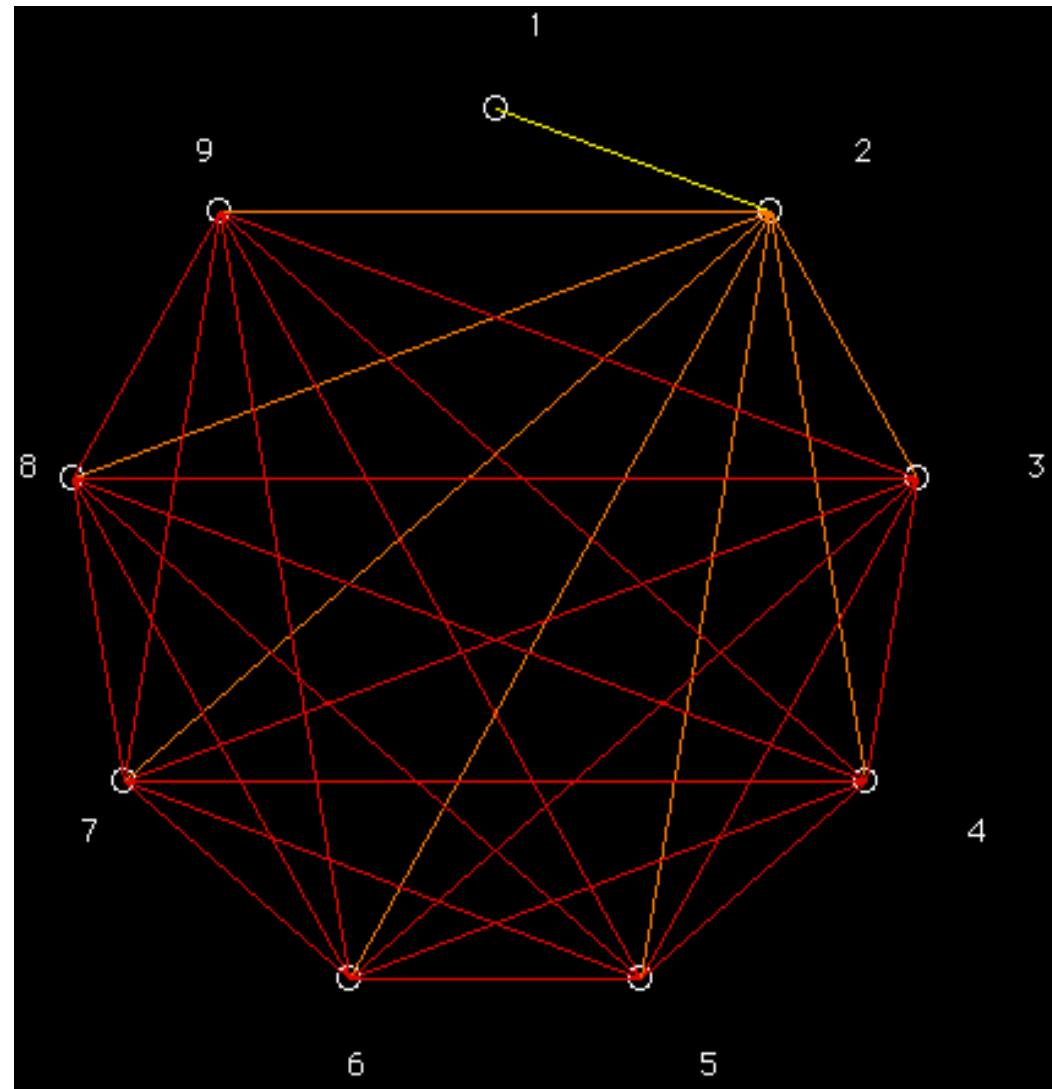
Figure 1. Partial correlation diagram: High ( red ), medium ( orange ) and low ( yellow ) correlations of pesticides.